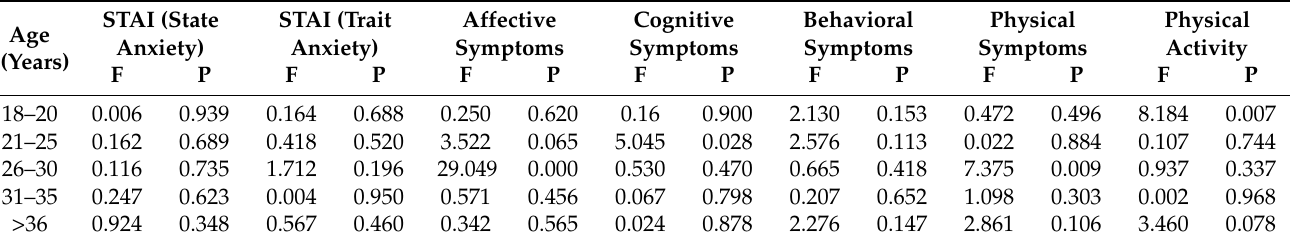
Table 5. Effects of age on STAI and students’